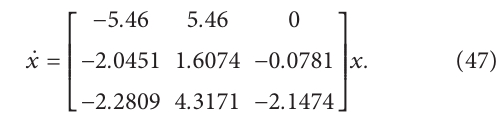
between robust solution and nonoptimized 3